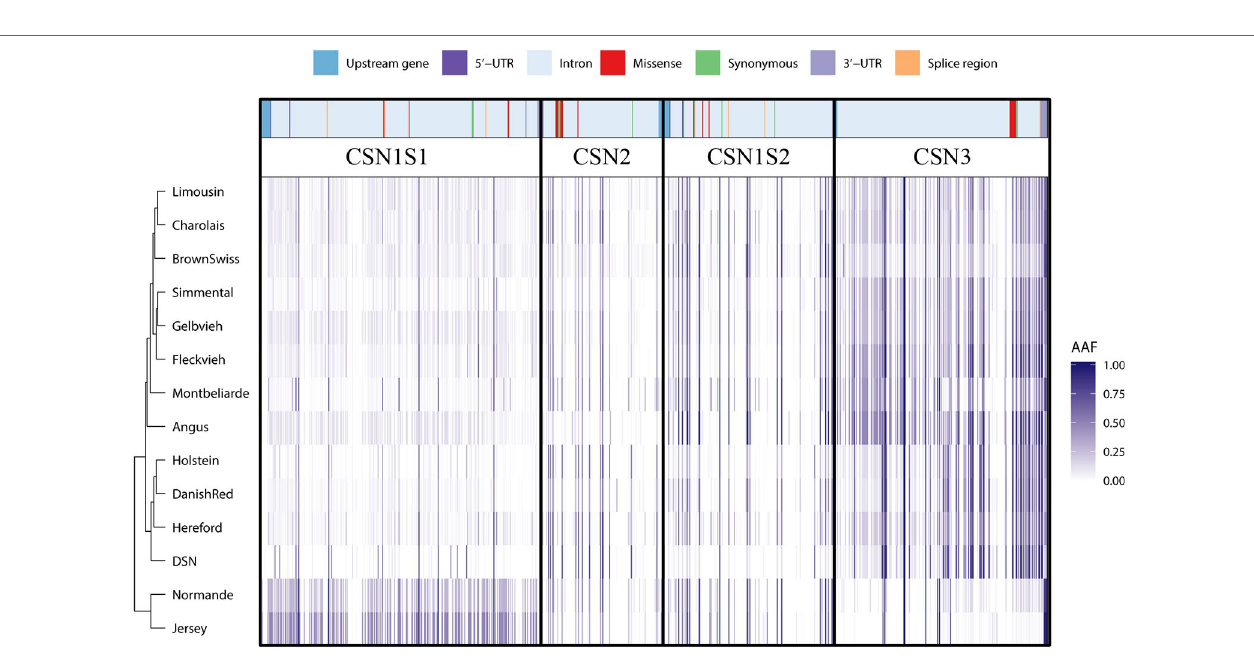
FIGURe 1 | Overview of variant types occurring within the four casein genes CSN1S1 , CSN1S2 , CSN2 , and CSN3 including their 1,000-bp upstream region.